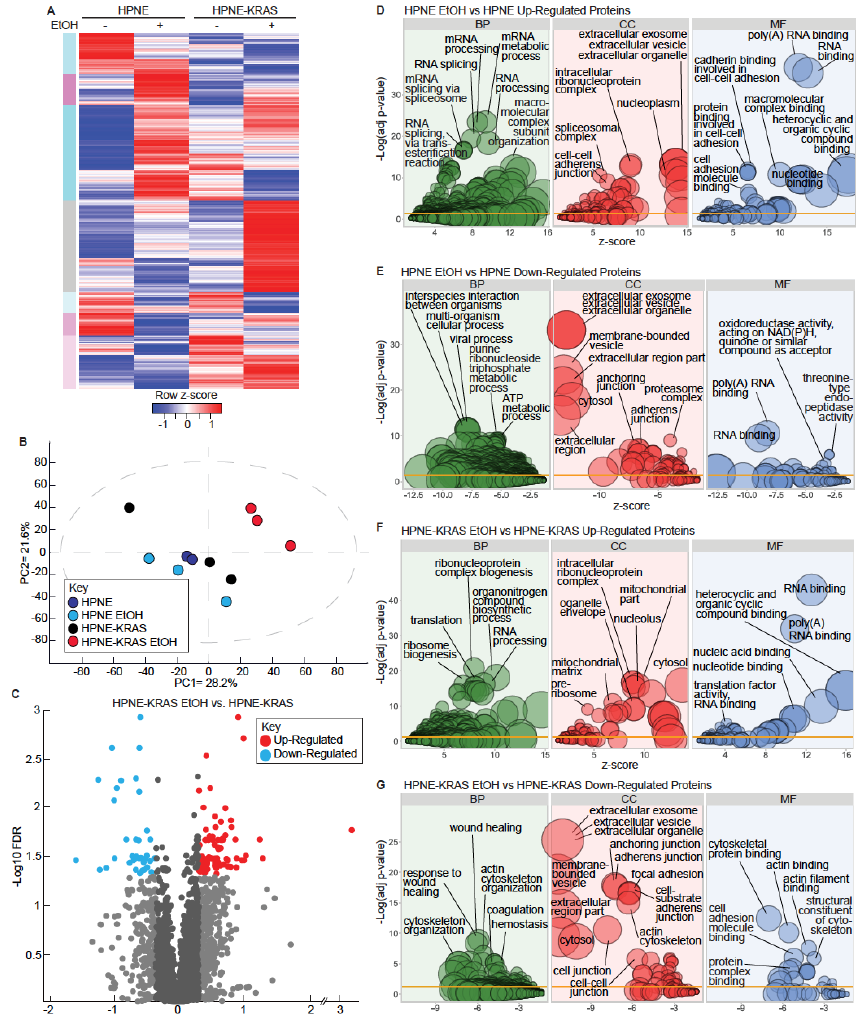
Figure 3. Quantitative proteomic analysis of the impact of EtOH and KRAS mutation in HPNE cells on protein expression. ( A ) Heatmap of the mean protein expression values for HPNE and HPNE- KRAS cells treated with or without EtOH. n = 3. ( B ) Principal Components Analysis (PCA) of the proteomics data for HPNE and HPNE-KRAS cells with or without EtOH conditioning. HPNE-2 was removed as an outlier. ( C ) Volcano plot of protein expression differences between HPNE-KRAS EtOH vs. HPNE-KRAS ( − log 10 p - value, determined by Student’s t -test). ( D – G ) Ethanol-conditioned cell lines were compared to untreated controls to select up and downregulated proteins (cutoff, fold- change ±1.25) for GO term enrichment analysis for the indicated comparisons. The DAVID bioin- formatics tool was used to identify enriched terms for up or downregulated proteins (analyzed in- dependently). The z-score (x-axis) was calculated by z-score = (up − down)/sq (count), where up and down are the number of assigned proteins upregulated or downregulated in the data, and count is the number of proteins assigned to a term. The bubble size is representative of the number of pro- teins present in the respective term. FDR was used for the adjusted p -values. We performed GO term enrichment analysis through DAVID to determine signifi- cant terms associated with differentially expressed proteins (±1.25-fold change) in both the HPNE and HPNE-KRAS cell lines (Figure 3D – G). Biological process (BP) terms en- riched in HPNE EtOH up-regulated proteins were primarily associated with RNA